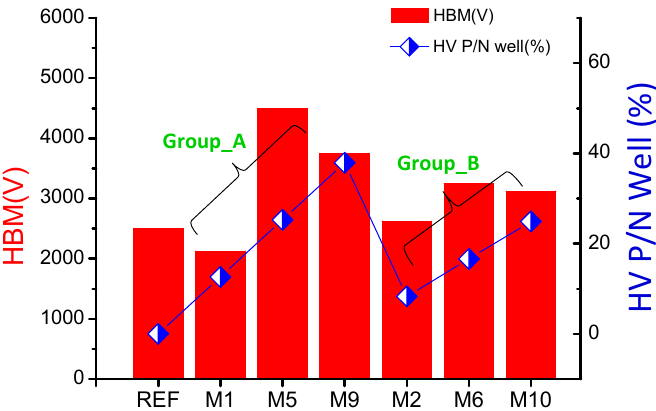
Figure 12. HBM values and SJ (HVPW) area % comparison of UHV 300 V GGnLDMOSs with di ff erent symmetrical four-zone SJs.